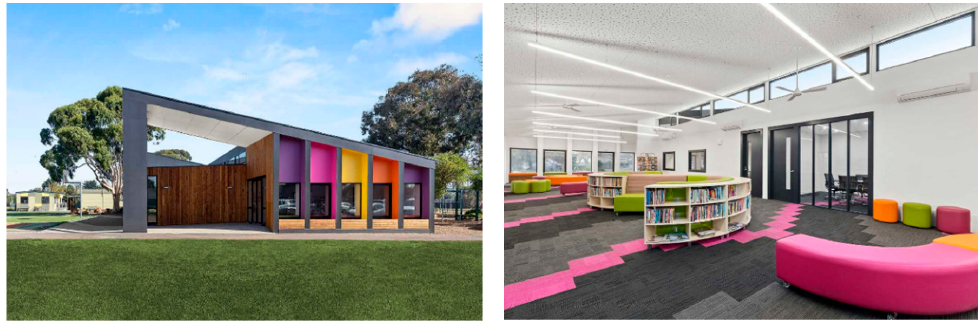
Figure 5. Altona South Primary School Library by Arkit. Images: Alessandro Cerutti.